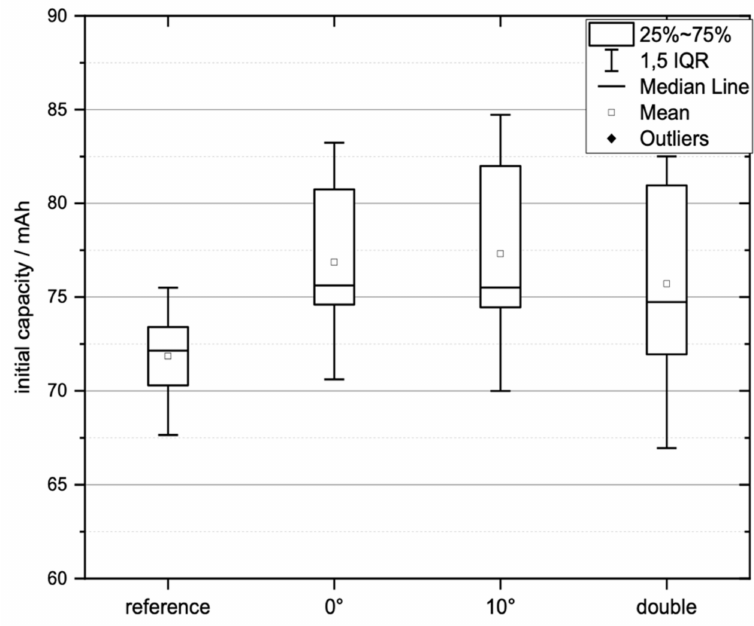
Figure 12. Discharge capacity of edge collision cells and reference